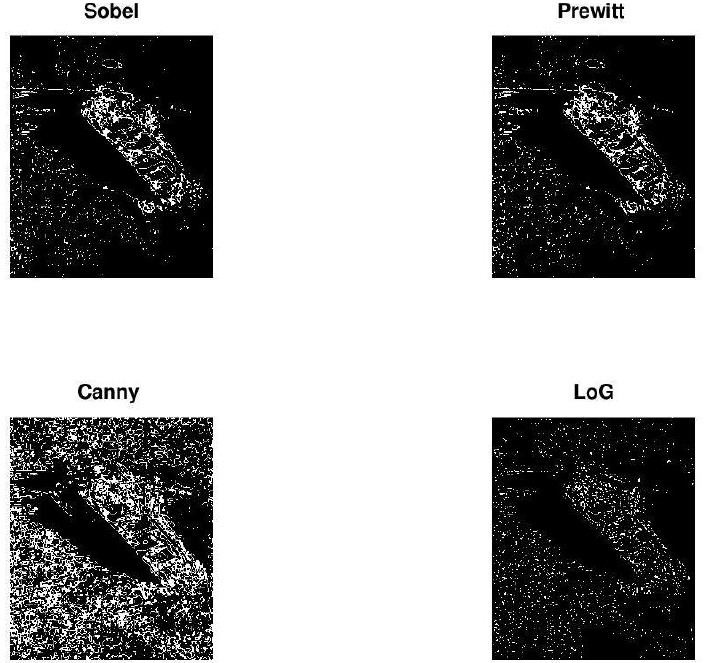
Figure 10. Result of closing on common edge detection